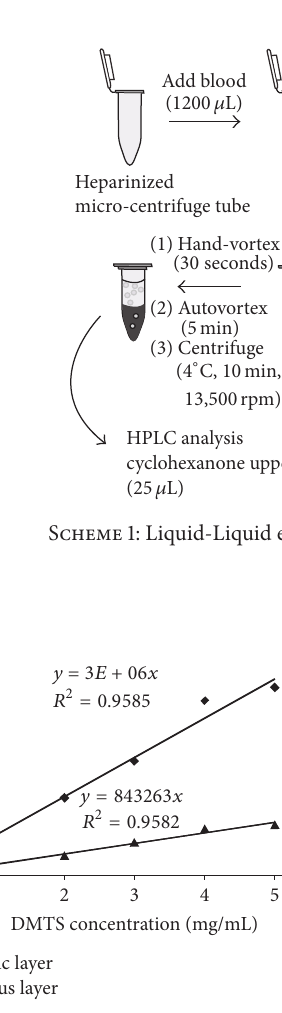
Figure 2: Partitioning of DMTS in 15% Poly80 (aqueous phase) and cyclohexanone (organic layer).